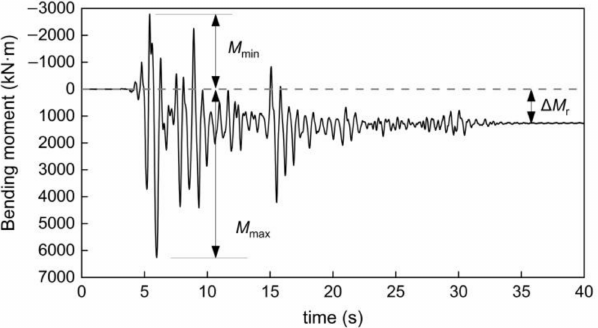
Figure 14. Typical response time–history curves of bending moments in the centrifuge test (EQ4, S3).